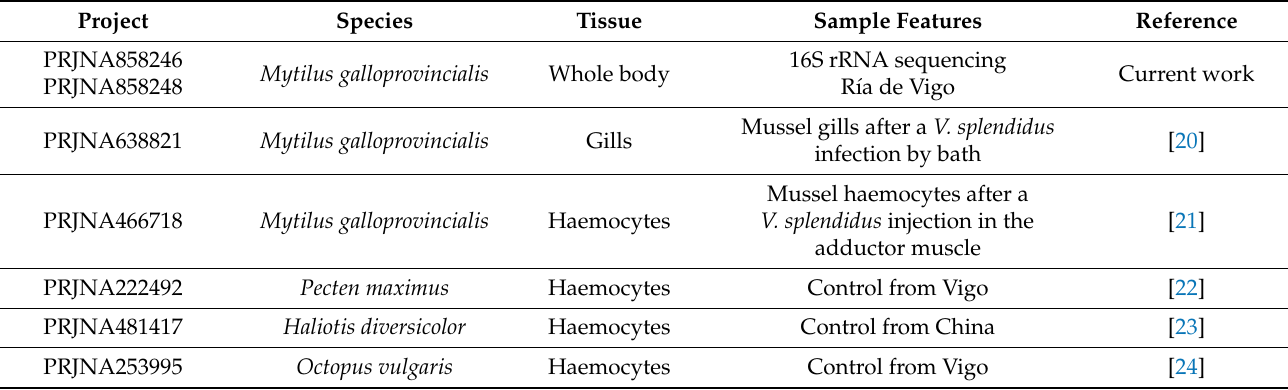
Figure 2. Methodological comparison: 16S rRNA sequencing vs. RNA sequencing. ( a ) Histogram showing the classes detected by 16S rRNA and metatranscriptomics. Taxa with combined abundances over 500 are shown. ( b ) Venn diagram showing the shared and exclusive orders among the three approaches. ( c ) Histogram showing relative abundances of orders shared among the three approaches. Table 1. General information about all the RNA-seq projects used in the current work.